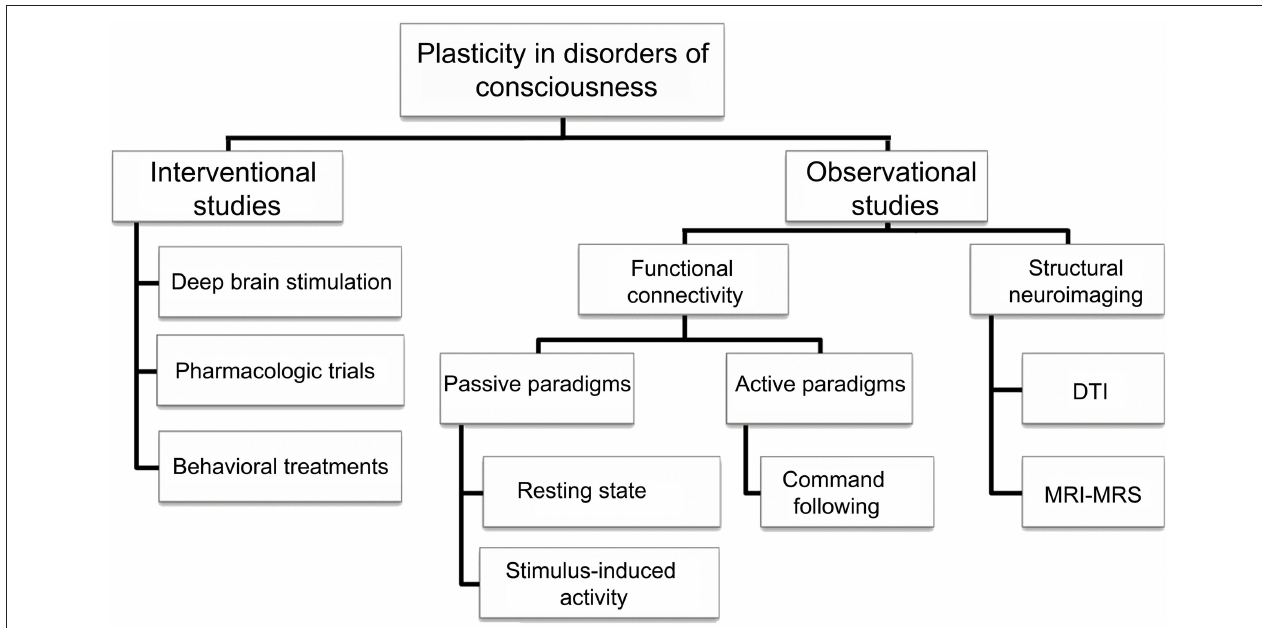
Figure 1 | Outline of studies dealing with plasticity issues in patients with disorders of consciousness. DTI, diffusion tensor imaging; MRI, magnetic resonance imaging; MRS, magnetic resonance